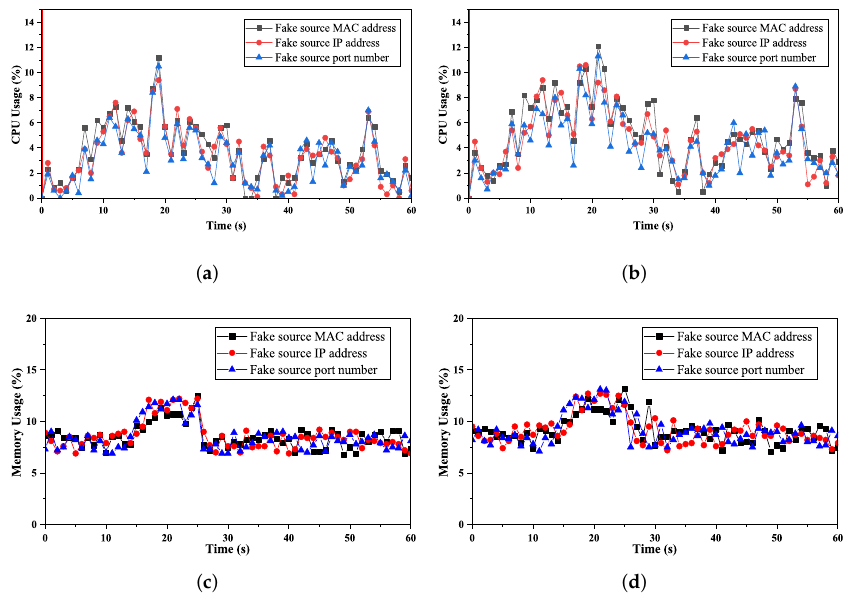
Figure 8. Overhead of the controller under the protection of DoSGuard. ( a ) 1000 packets/s.